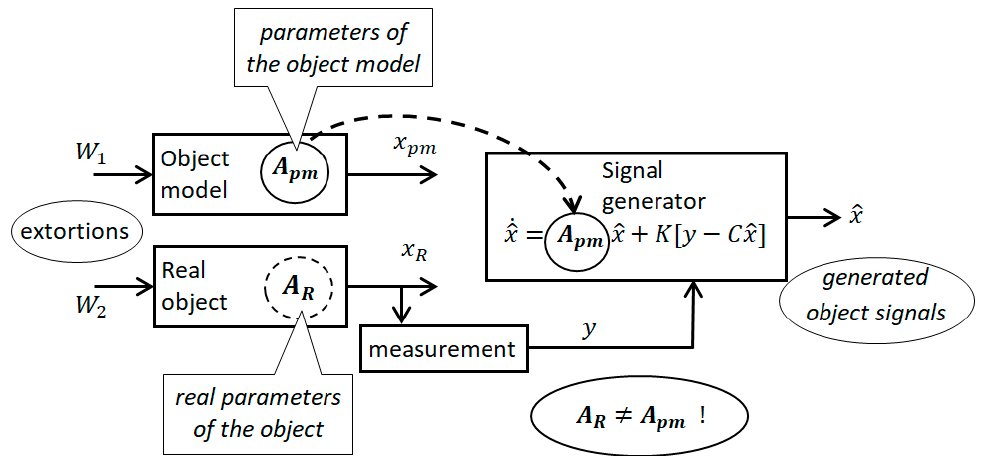
Figure 5. Schematic diagram of generating object signals with inaccurate model parameters.